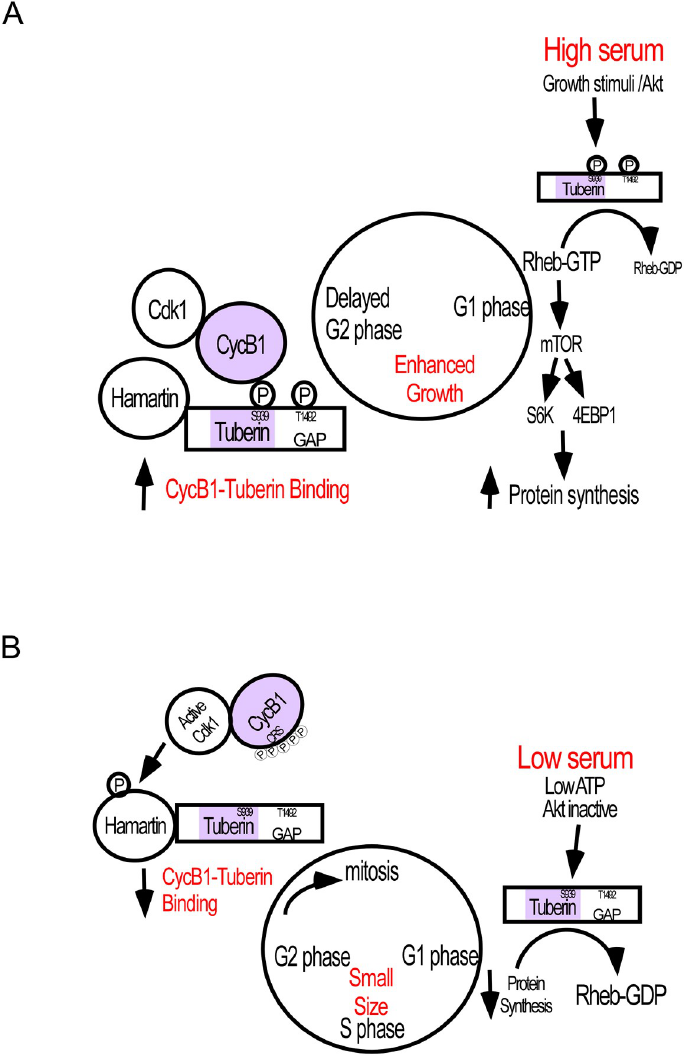
Fig 4. Model of Tuberin regulation of the cell cycle in response to serum status. (Top Panel) In the presence of serum Tuberin is phosphorylated by Akt and able to bind to CycB1 and delaying movement through mitosis, thereby enabling cell growth. ( Bottom Panel) In the absence of serum, unphosphorylated Tuberin has reduced binding to Cyclin B1. This promotes entry of Cyclin B1 into the nucleus and mitotic progression and limits cell growth.